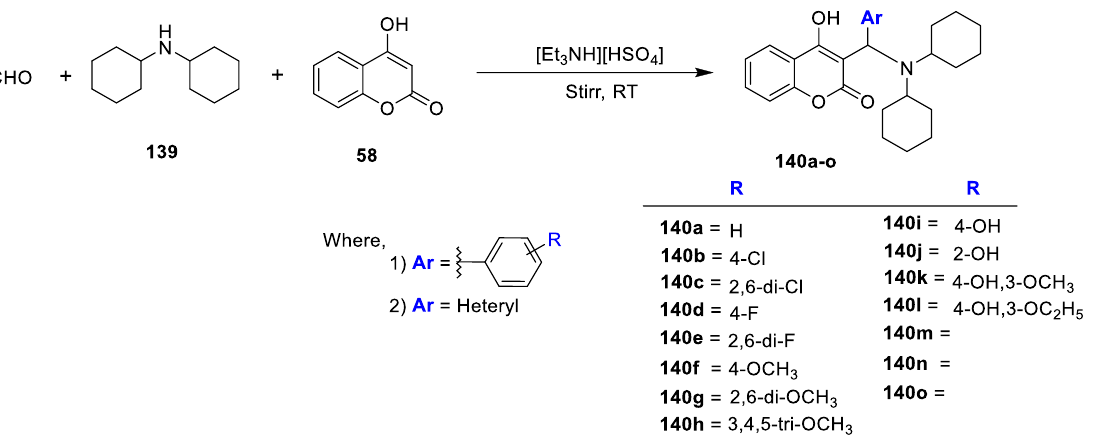
Scheme 30 . One – pot three – component synthesis routes for analogues 140a – o . Adapted